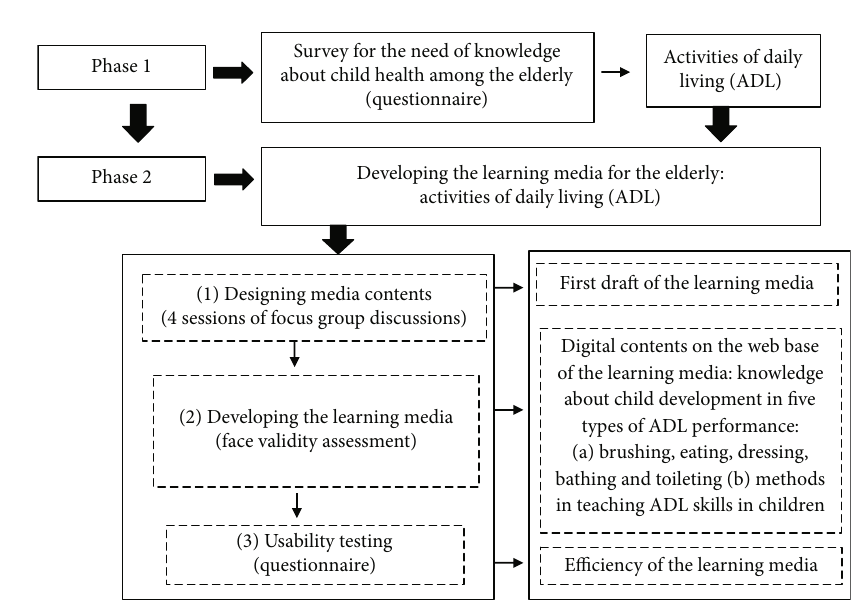
Figure 3: Two main sections of the knowledge media.